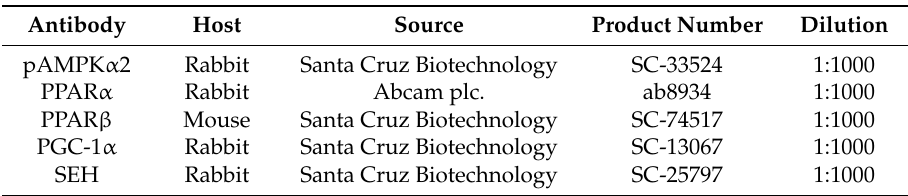
Table 2. Antibodies used for Western